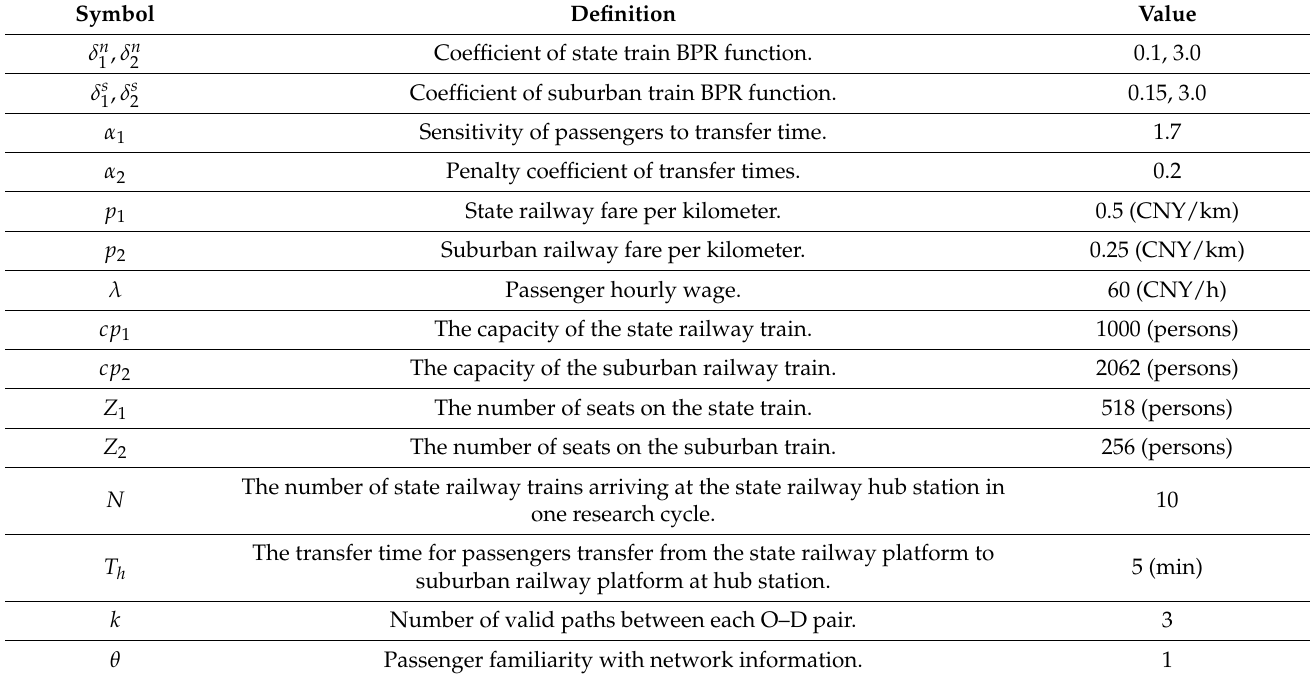
Table 5. Parameters used in this paper.